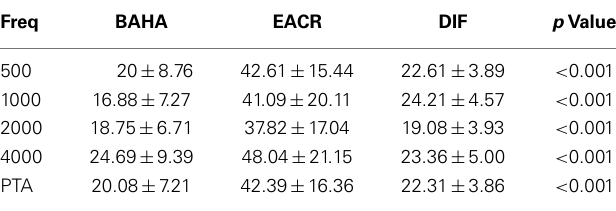
Table 3 | Short-term post-operative hearing thresholds comparison between BAHA and EACR .